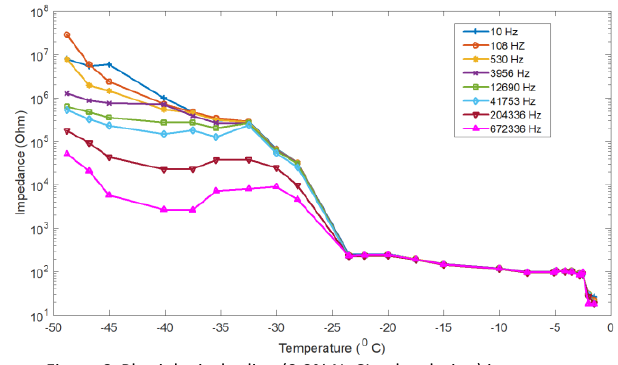
Figure 6. Physiological saline (0.9% NaCL salt solution) ice impedance of selected frequencies as a function of temperature measured during heating (unfrozen process)